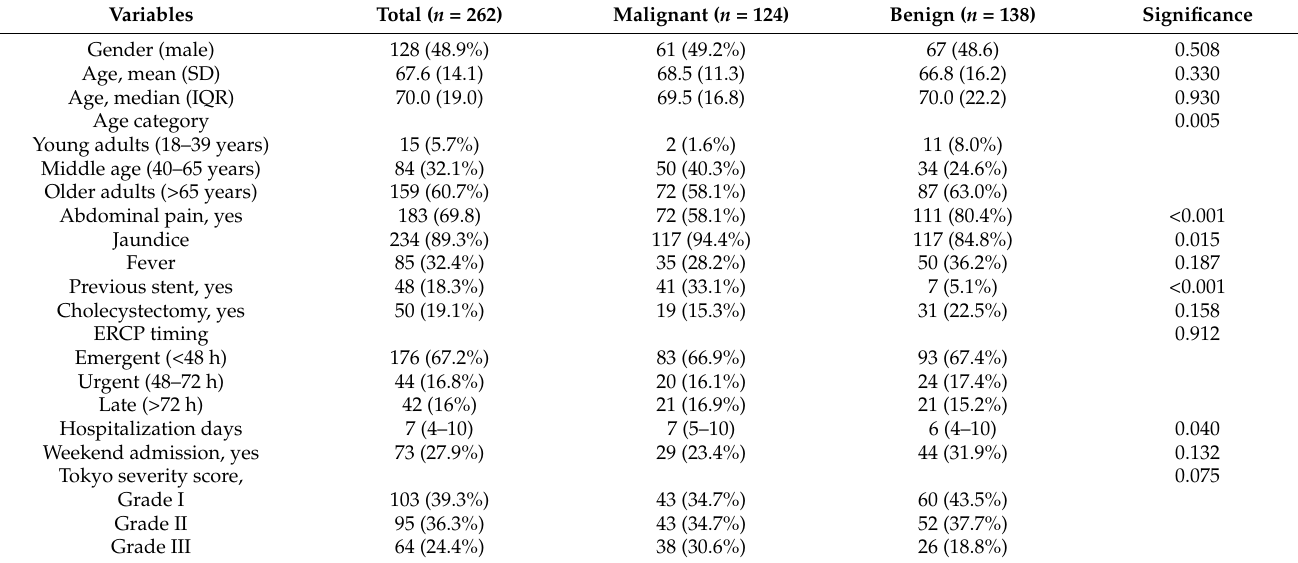
Table 2. Clinical characteristics of the study population stratified by etiology of biliary